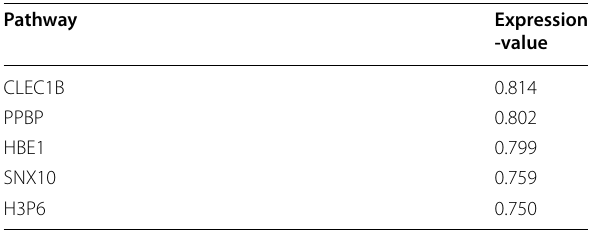
Table 4 The most differentially expressed protein-coding genes (most overexpressed) Pathway Expression